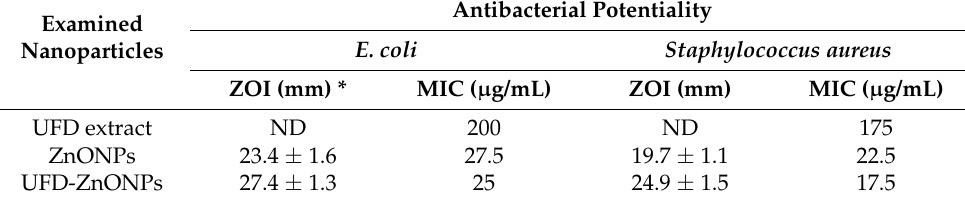
Table 1. Antimicrobial potentialities of phycosynthesized annealed zinc oxide nanoparticles ( ZnONPs ), Ulva fasciata Delile extract (UFD extract) and their nanocomposite ( UFD-ZnONPs ) against bacterial